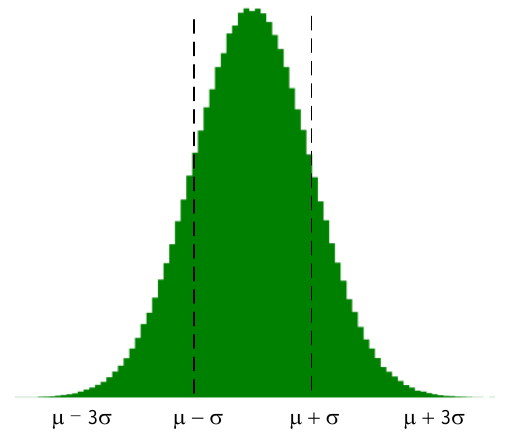
Figure 3. Gradient